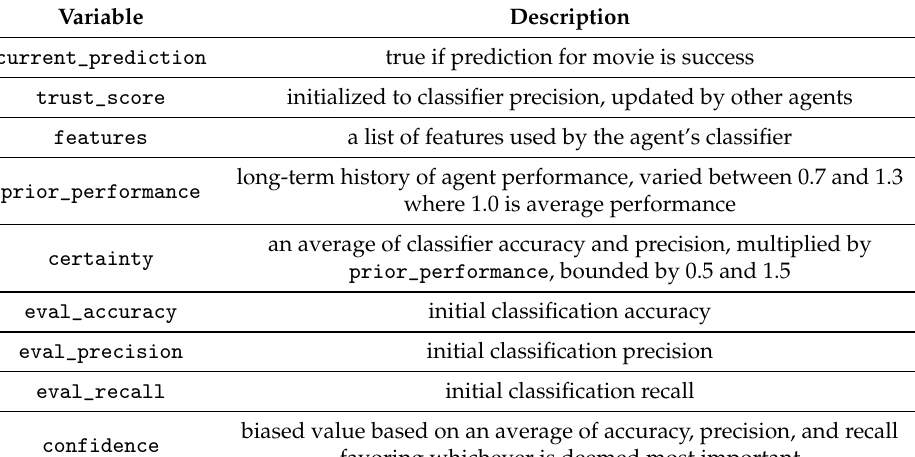
Table 2. Internal scoring